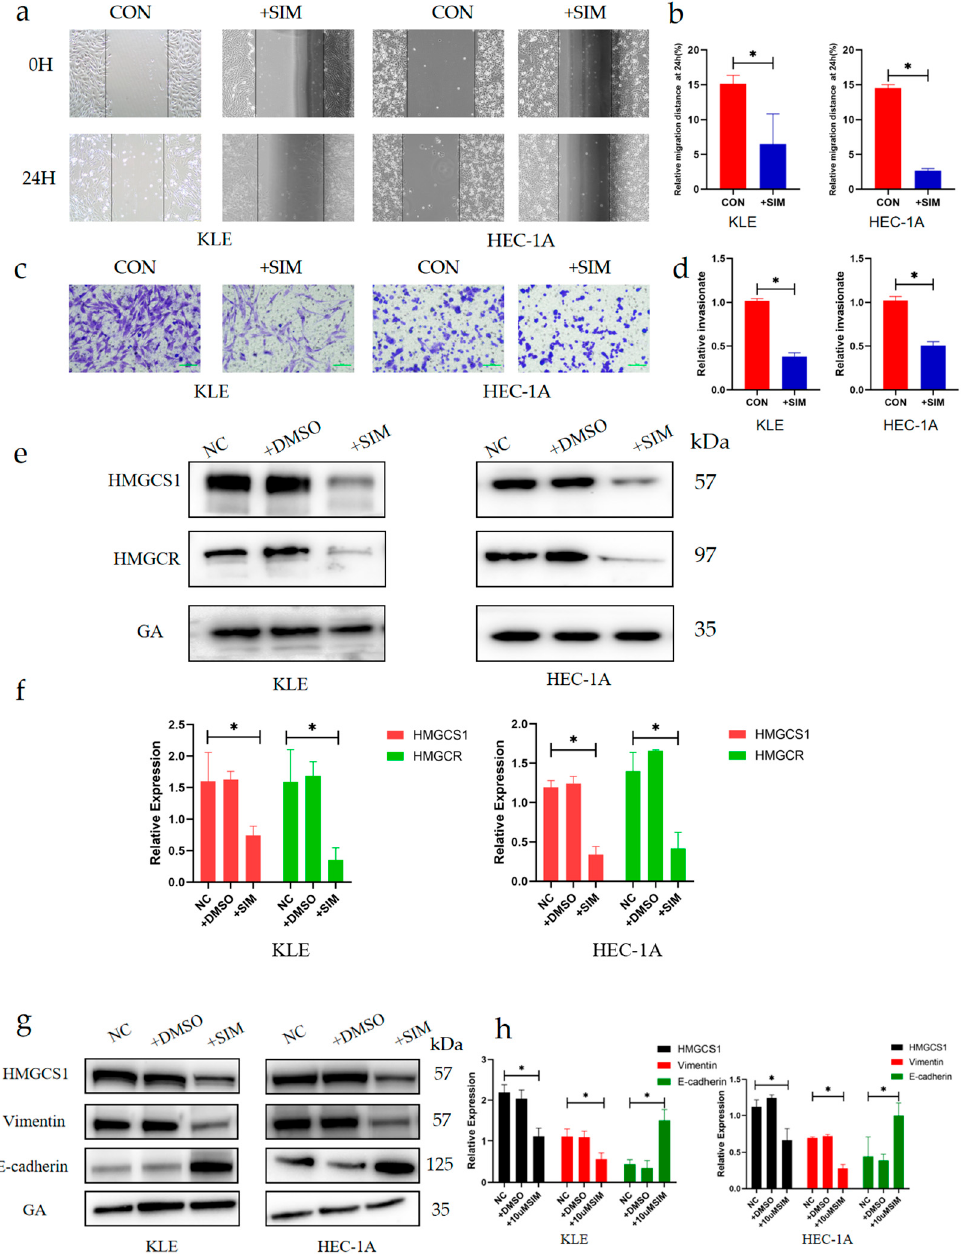
Figure 3. Simvastatin inhibits the epithelial-mesenchymal transition in EC. ( a – d ) The migration abilities of EC cells after simvastatin treatment and statistical analysis results (magnification, 200 × ; scale bars, 100 µ m). ( e , f ) The expression levels of 3-hydroxy-3-methyl-glutaryl-coenzyme A reductase (HMGCR) and HMGCS1 after up- and down-regulation of ERR α expression, and the statistical analysis results. ( g , h ) The expression levels of EMT-related proteins after simvastatin treatment. SIM: Simvastatin. *, indicates statistical significance. Statistical tests: Student’s t -test.